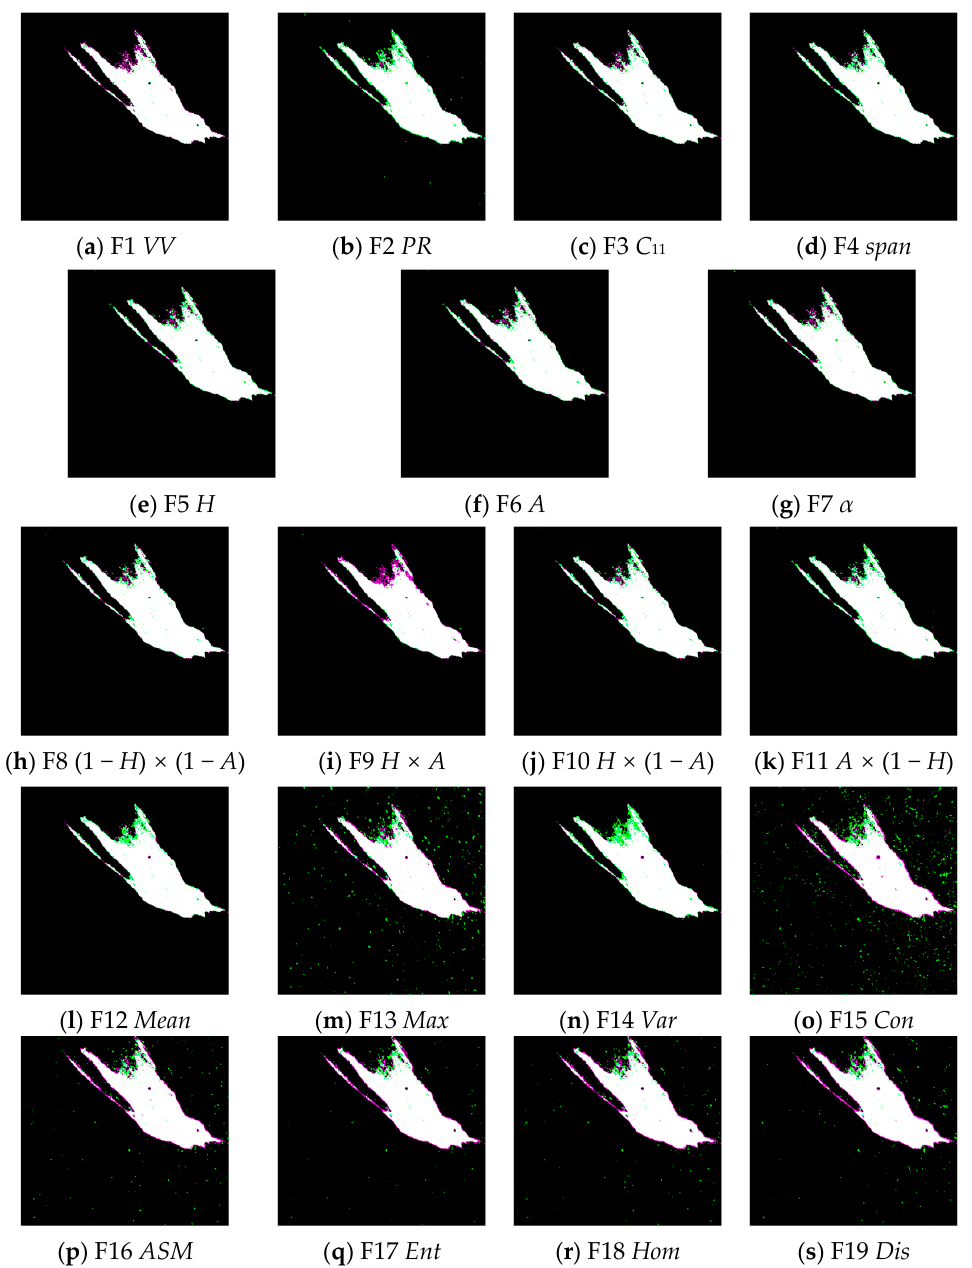
Figure 12. Evaluation results for data a based on J–M/K-means algorithm.